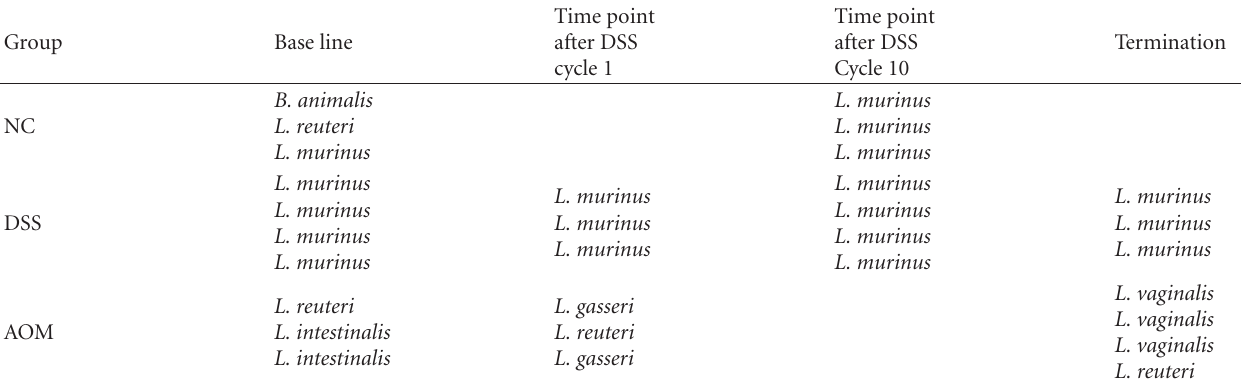
Table 4: Faecal flora. Identification of isolates from plate count of faeces from di ff erent rat groups ( L. = Lactobacillus and B . = Bifidobacterium ).